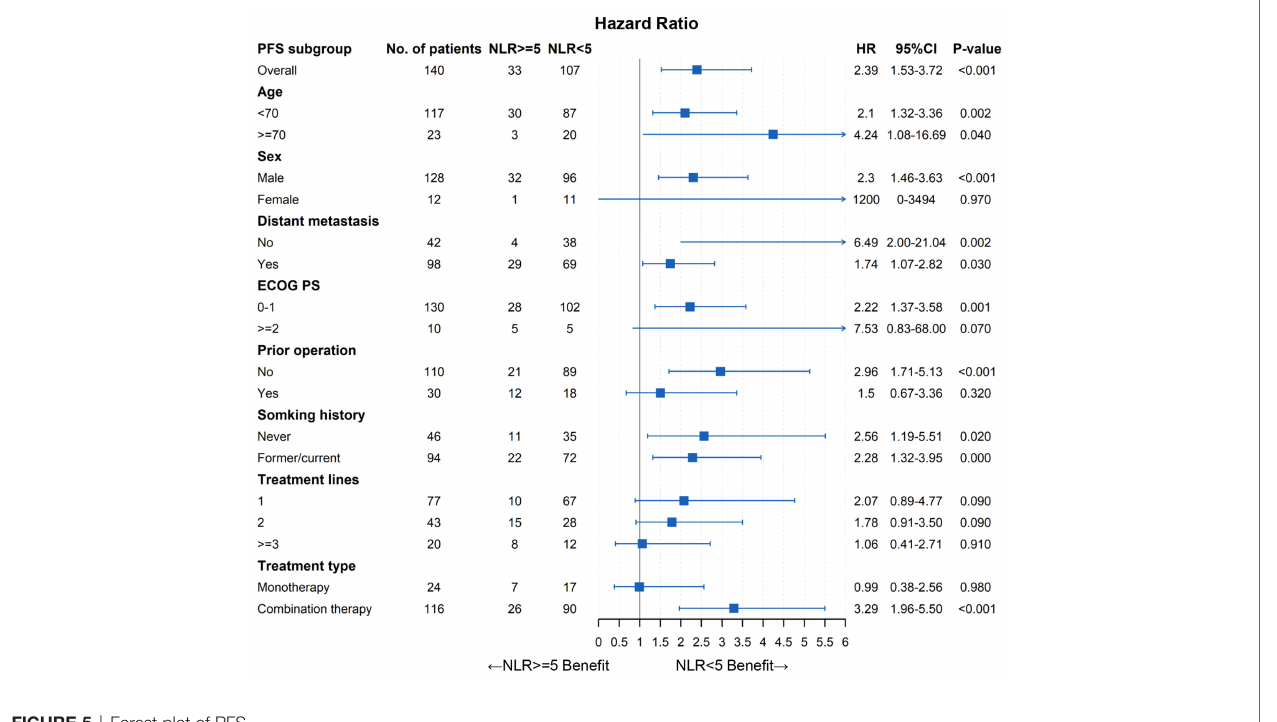
FIGURE 5 | Forest plot of PFS.